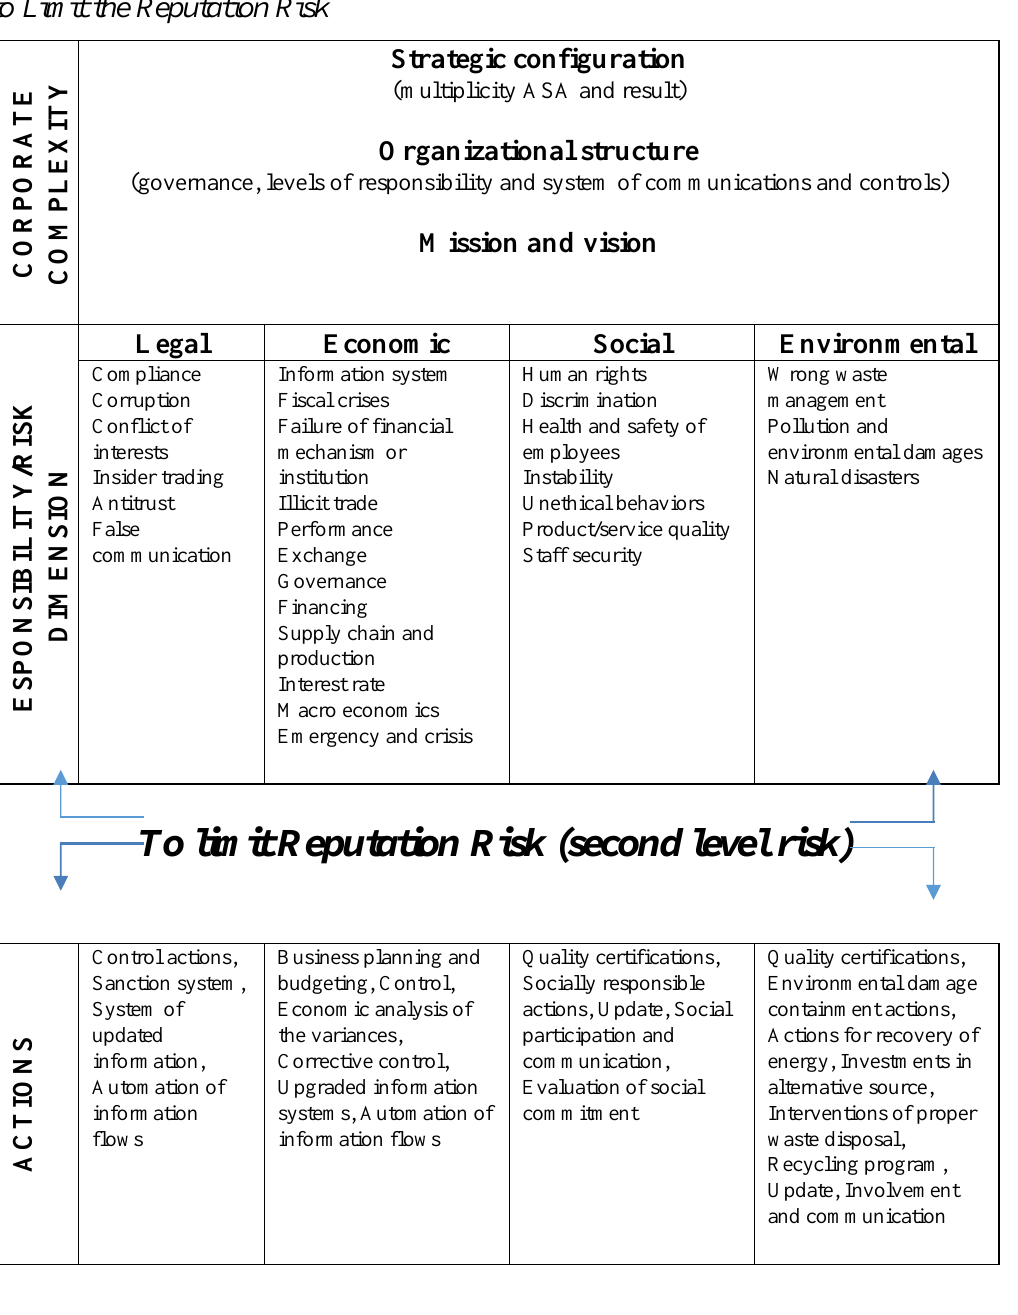
Table 2: Relationship between Responsibility/Risks Dimension and Actions/Tools to Limit the Reputation